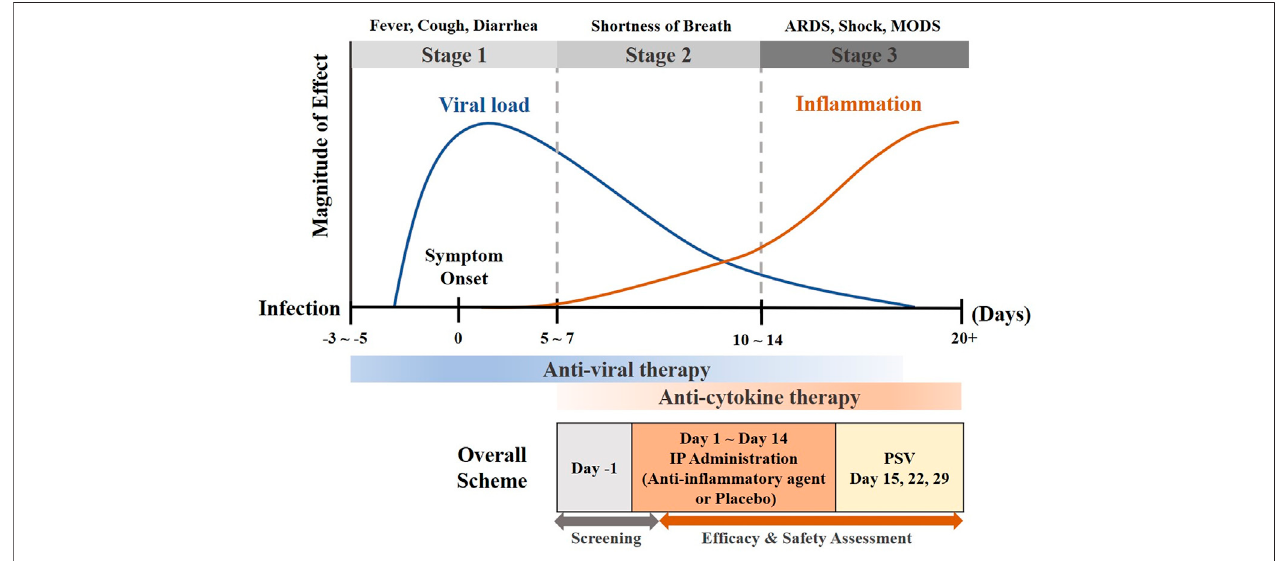
FIGURE 1 | Clinical time course of COVID-19 and study design (adapted from (Aguilar et al., 2020)) Abbreviations: ARDS, acute respiratory distress syndrome; COVID-19, coronavirus disease of 2019; IP, investigational product; MODS, multiple organ dysfunction syndrome; PSV, post-study visit.